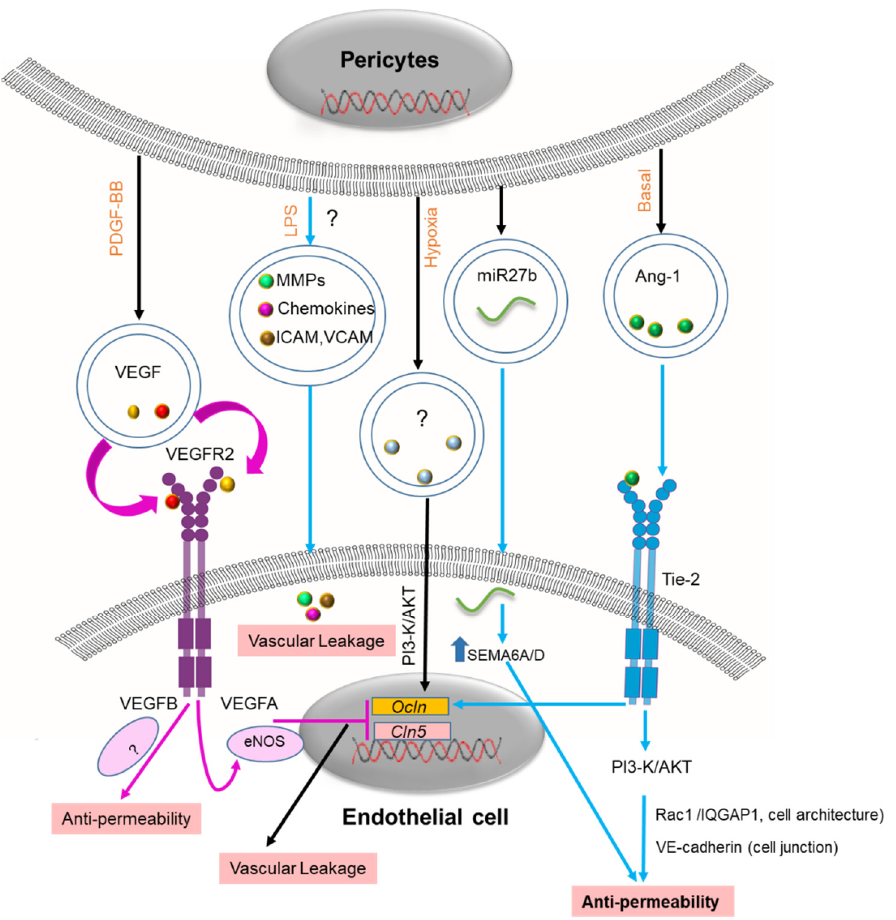
Figure 3. Postulated mechanisms of PC-EVs in the BBB. In response to PDGF-BB, PC-EVs release VEGF to recipient endothelial cells (ECs). VEGF-A inhibits the expression of tight junction proteins such as Ocln and Cln5 through an eNOS signaling pathway, inducing vascular leakage. EVs contain various miRNAs that regulate BBB integrity when transferred to ECs. Among them, miR7b acts by targeting SEMA6A/D, enhancing endothelial barrier function. Hypoxia-induced PC-EV release increases Ocln and Cln5 protein expression by activating the PI3K/Akt pathway. The exact cargo of the PC-EVs has not been reported. Ang-1 released by PC-EVs act on the Tie-2 receptor and promote barrier function by enhancing Ocln gene expression. Ang-1/Tie2 targets the PI3/Akt signaling pathway to promote the expression of cellular junction protein (VE-cadherin), thereby strengthening the cellular architecture. LPS-induced secretion of inflammatory mediators (MMP9, chemokine) and adhesion molecules (ICAM, VCAM) from PCs may promote vascular leakage. PC-EV content released by stimulation with LPS has not yet been reported. The black arrow indicates identified components and mechanism of action of PC-EVs, and the magenta arrow indicates hypothesized Mechanism in PC-EVs based on identified mechanisms from other EVs. The blue arrow indicates the speculative mechanism (miRNA: an acronym for micro RNA; PCs: pericyte; EVs: extracellular vesicles; VEGF: Vascular endothelial growth factor; PI3K: phosphoinositide 3-kinase; Ocln: Occludin; Cln5: Claudin-5; ICAM: intercellular adhesion molecule 1; VCAM: Vascular cell adhesion 1; MMPs: matrix metalloproteinases; Ang-1: angiopoietin-1; BBB: Blood–brain barrier). “?” indicates the content of the PC-EVs is not